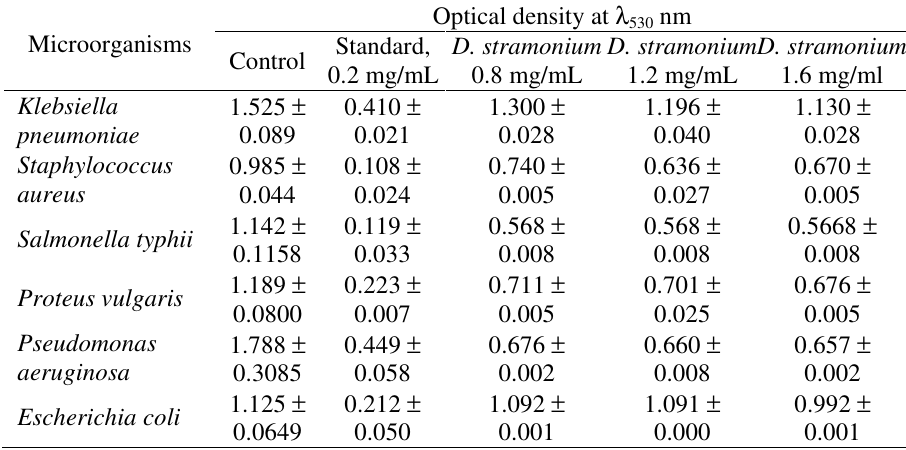
Table 1. Evaluation of the antimicrobial bioassay of ethanolic extract of Datura stramonium L